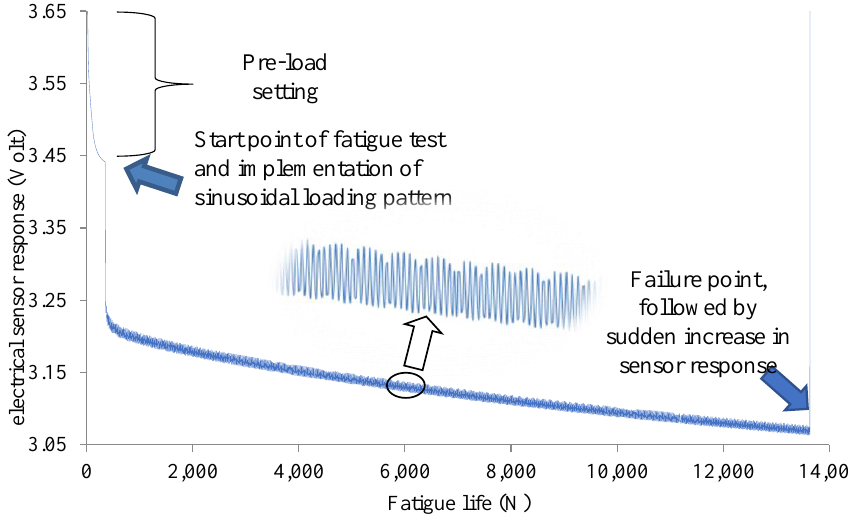
Figure 9. Electrical response of self-sensing concrete during the fatigue test.